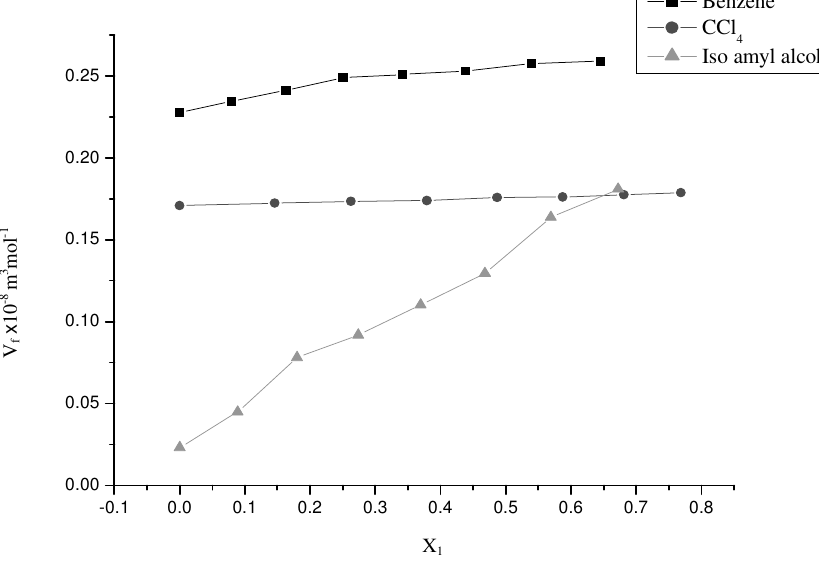
Figure 2. Variation of free volume ( V